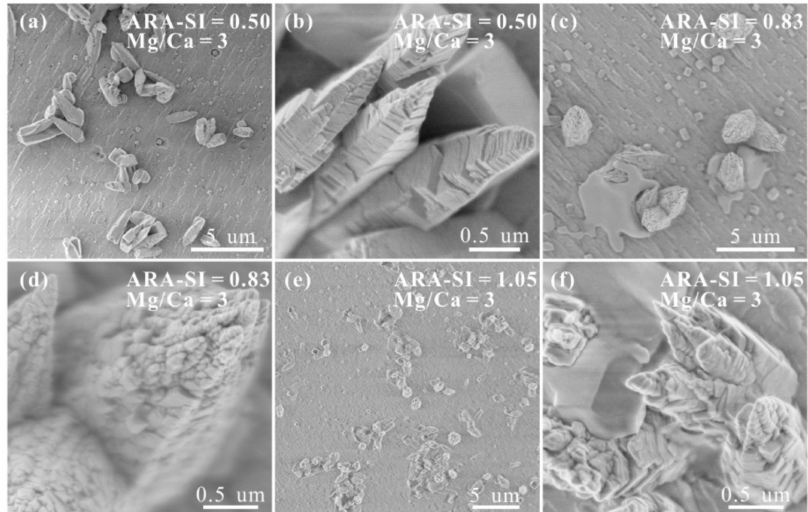
Figure 9. SEM images of the polished aragonite (110) surfaces after growing in solutions with Mg 2 + / Ca 2 + = 0 and ( a , b ) SI = 0.50; ( c , d ) SI = 0.83; ( e , f ) SI = 1.05. calcite calcite calcite